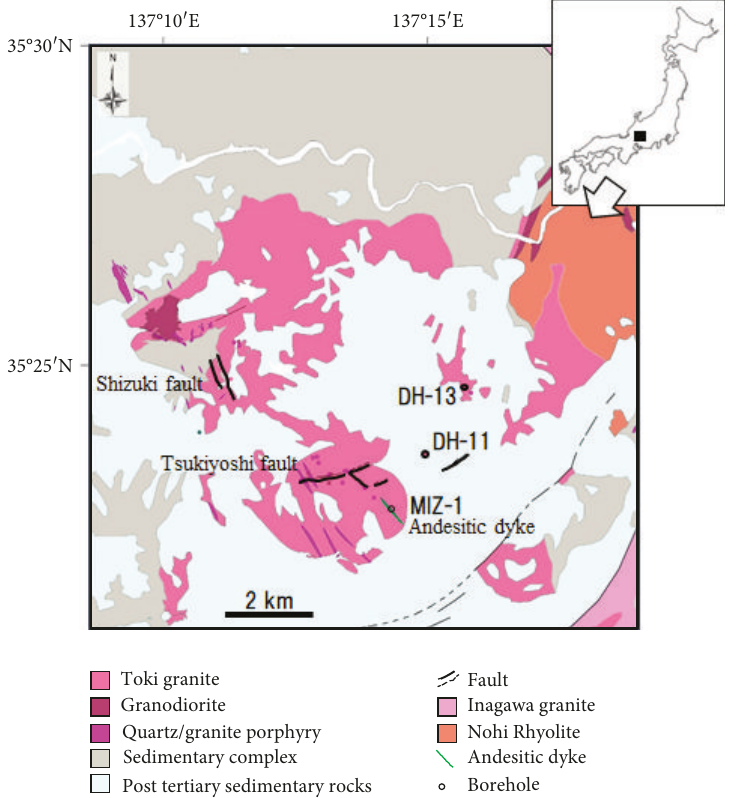
Figure 1: Geological map in and around the Toki granite. Distribution of the Toki granite, dike, and surrounding rocks. Based on data from existing boring surveys, some distributions of granites and intrusive rocks covered with post-Tertiary sedimentary rocks are